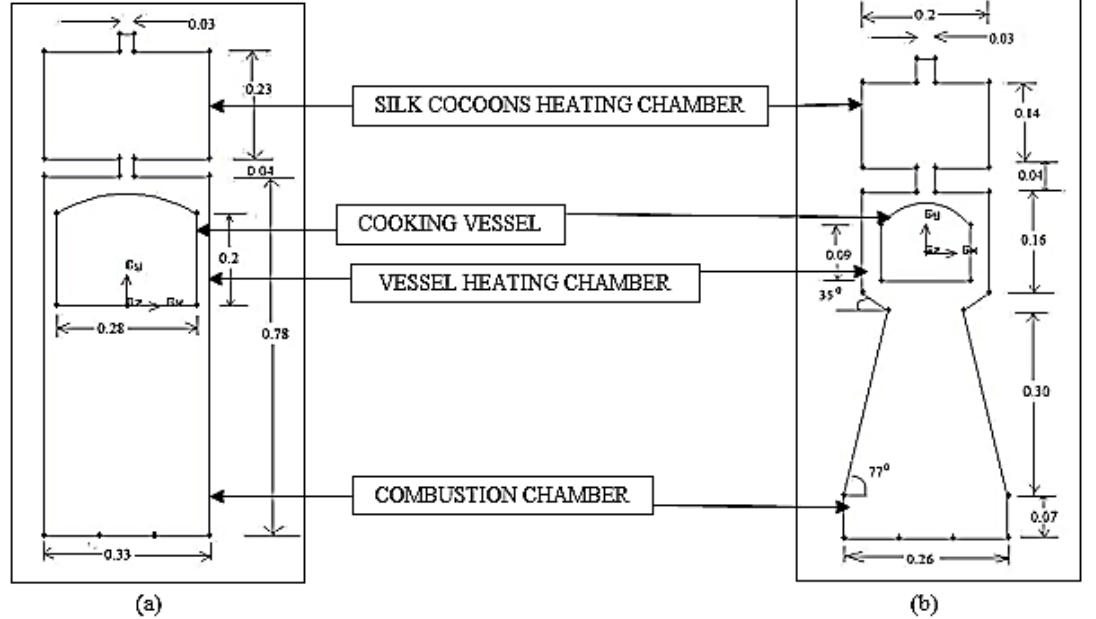
Figure 1. Schematic diagram of (a) system having cylindrical boiling chamber and channel type combustion chamber and (b) system having cylindrical boiling chamber and nozzle type combustion chamber.